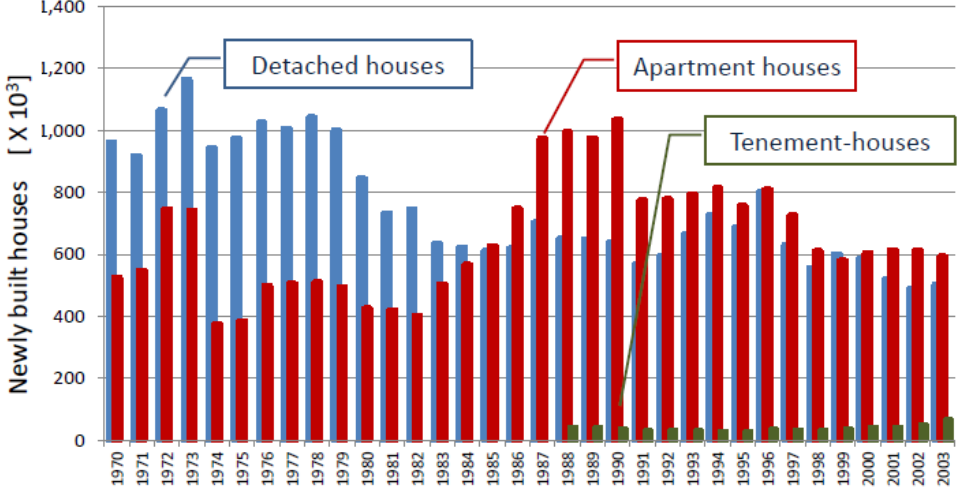
Figure 3. Changes in the numbers of newly built houses in